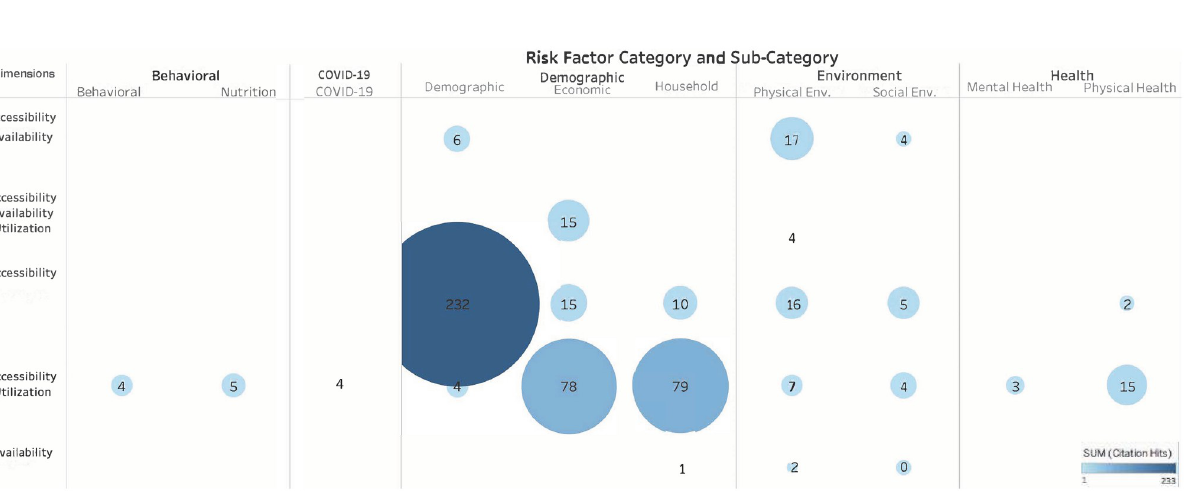
Fig 2. Dimensions of food insecurity Evidence and Gap Map (EGM). This diagram depicts the sum of citation hits (1–233) per risk factor category (behavioural, COVID-19, demographic, environment, and health) and how each category is mapped to the dimensions of food insecurity (accessibility, availability, and